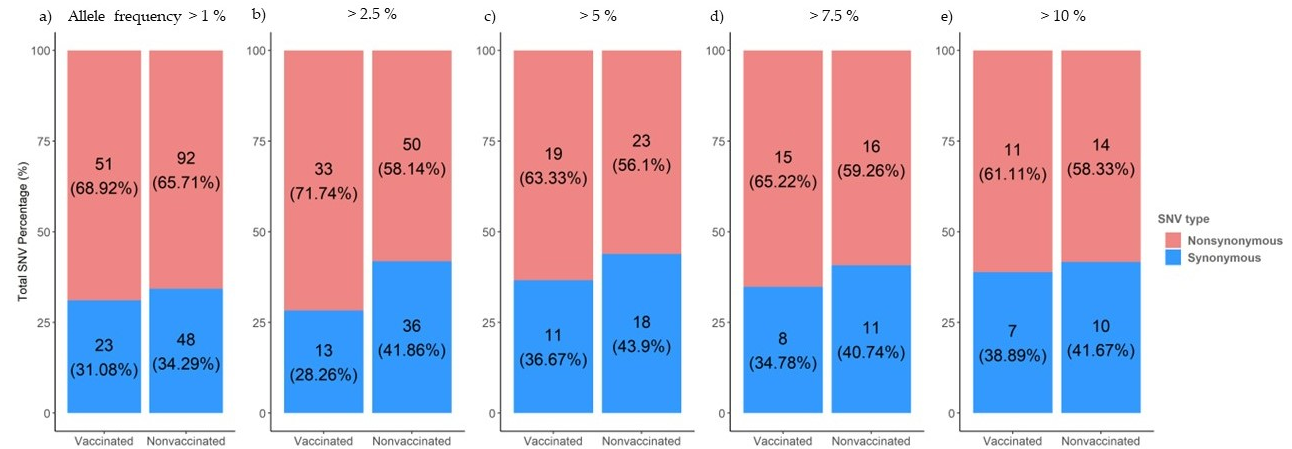
Figure 6. Proportion of synonymous and nonsynonymous de novo SNVs generated in sequences collected from vaccinated and nonvaccinated pigs. Substitutions with an allele frequency greater than 1% ( a ), 2.5% ( b ), 5%( c ), 7.5% ( d ), and 10% ( e ) are represented.